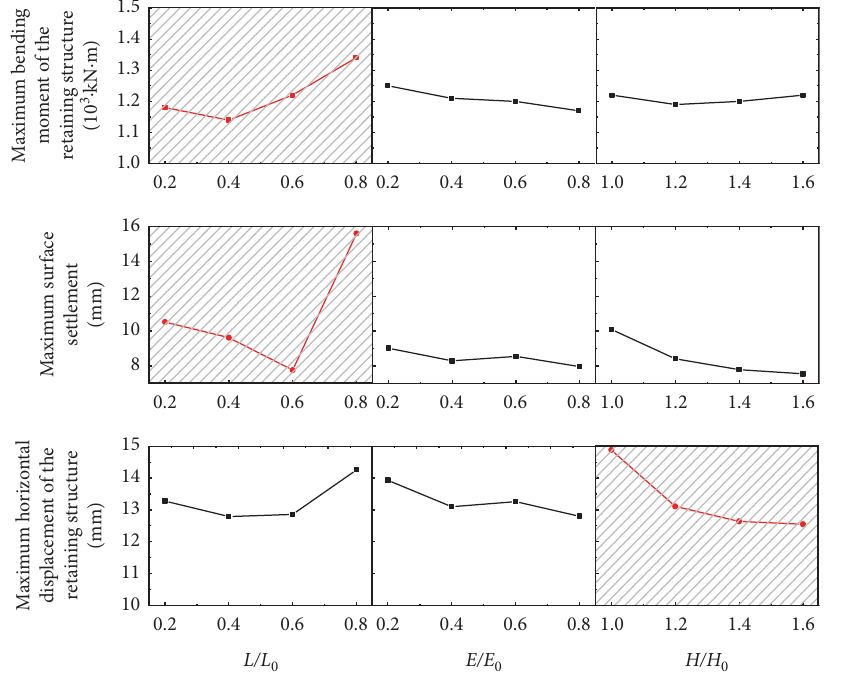
Figure 6: Trends of the affection at different levels.